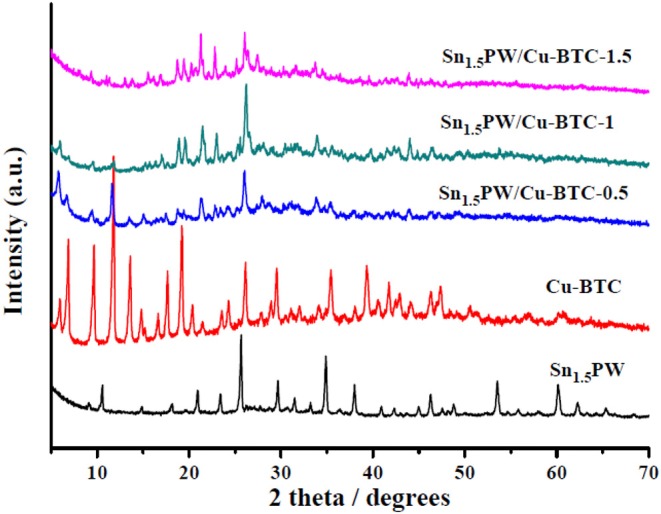
Wide-angle XRD patterns of the Sn1.5PW, Cu-BTC, and Sn1.5PW/Cu-BTC-x hybrids.